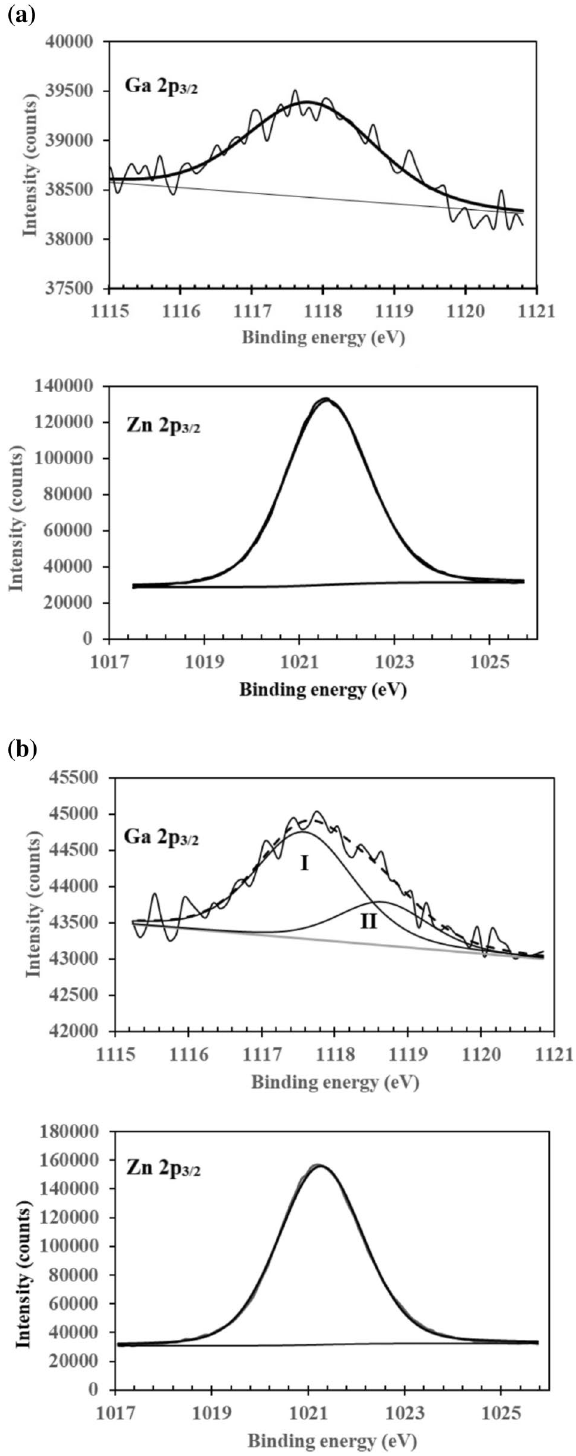
Figure 6. The XPS Ga 2p 3/2 and Zn 2p 3/2 spectra of the ( a ) 1 wt% and ( b ) 7 wt%